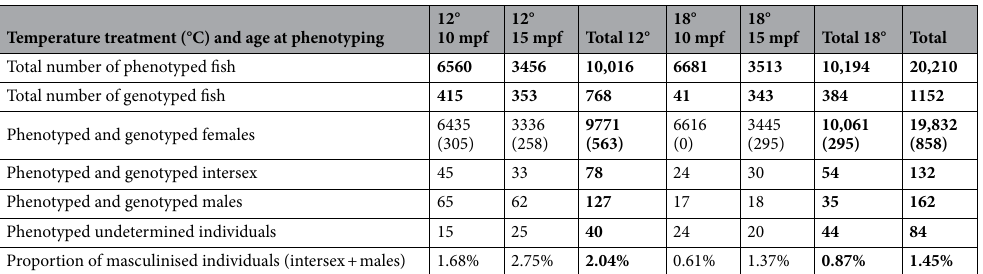
Table 2. Phenotyping and genotyping dataset from the XX-rainbow trout produced at “ Les fils de Charles Murgat” farm. mpf months post-fertilisation. Total number of fish are highlighted in bold.